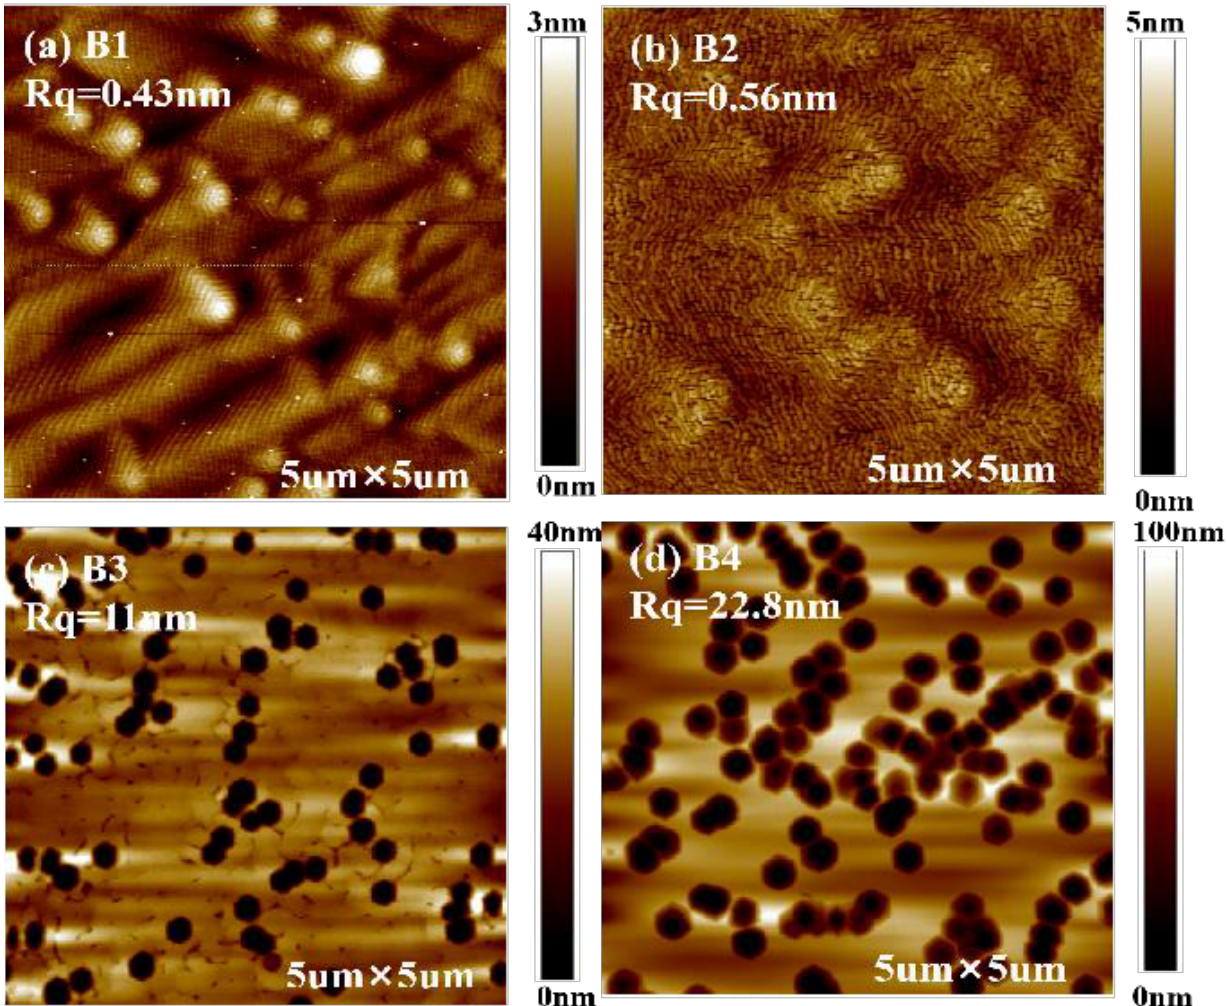
Figure 2. ( a – d ) are, respectively, 5 × 5 μm AFM images for sample B1, B2, B3 and B4. The corre- sponding metal source shutter closing time of samples B1, B2, B3, and B4 are 2.5 s, 5 s, 10 s, and 20 s, respectively. The metal source shutter opening time is kept constant of 10 s.